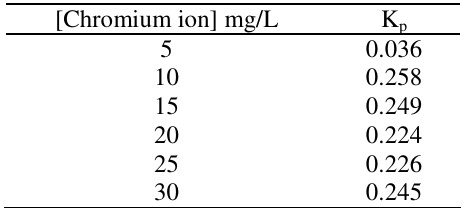
Table 7. Intra-particle diffusion (K